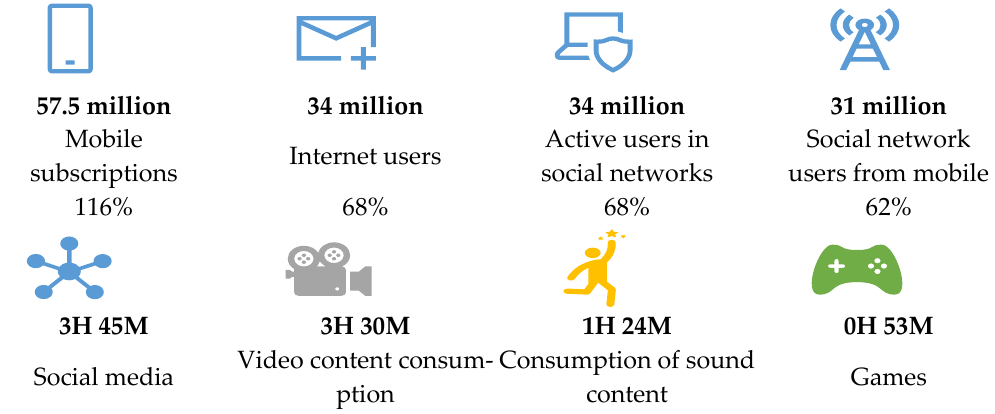
Figure 1. Penetration of the digital ecosystem in Colombia. Source: Prepared by author with Hootsuite data [23].